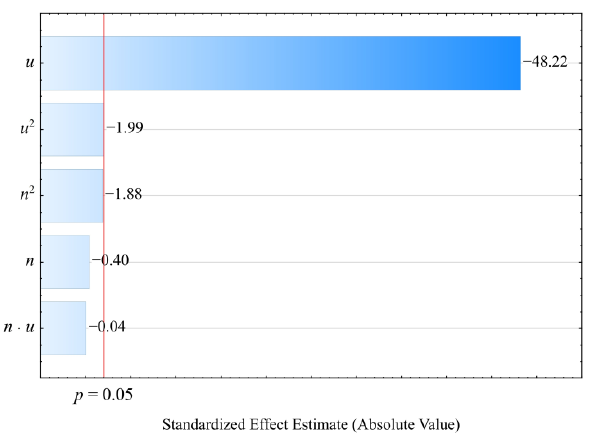
Figure 1. Pareto charts of the standardized effects for the empirical model of longitudinal shrinkage S L ; the vertical line in the plot corresponds to the arbitrarily chosen level of significance ( p = 0.05).